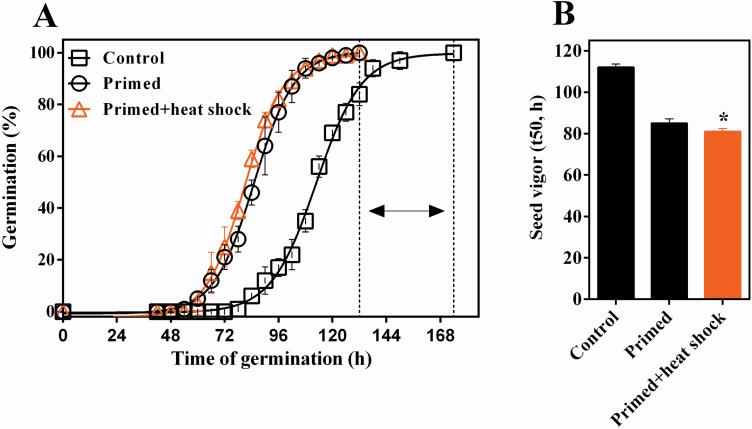
Priming and heat shock treatment improve physiological performance in S. lycopersicum seeds. Germination curves (A) and seed vigor—t50 (B) in S. lycopersicum seeds control non-primed, primed and primed+heat shock treatment (38 °C/32 % RH).. *Significance difference (P ≤ 0.05) by t-test between primed and primed+heat shock samples (n = 4). Error bars show standard deviation.